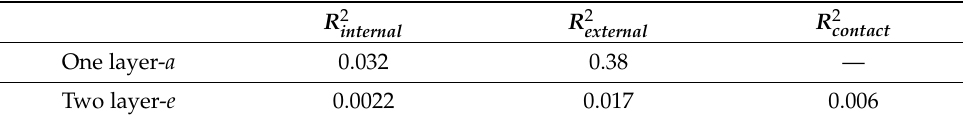
Figure 9. Comparison of the results of FEM model and COMSOL for the wall configurations of a and e shown in Figure 3. Table 2. Root mean square ( R 2 ) analysis between FEM and